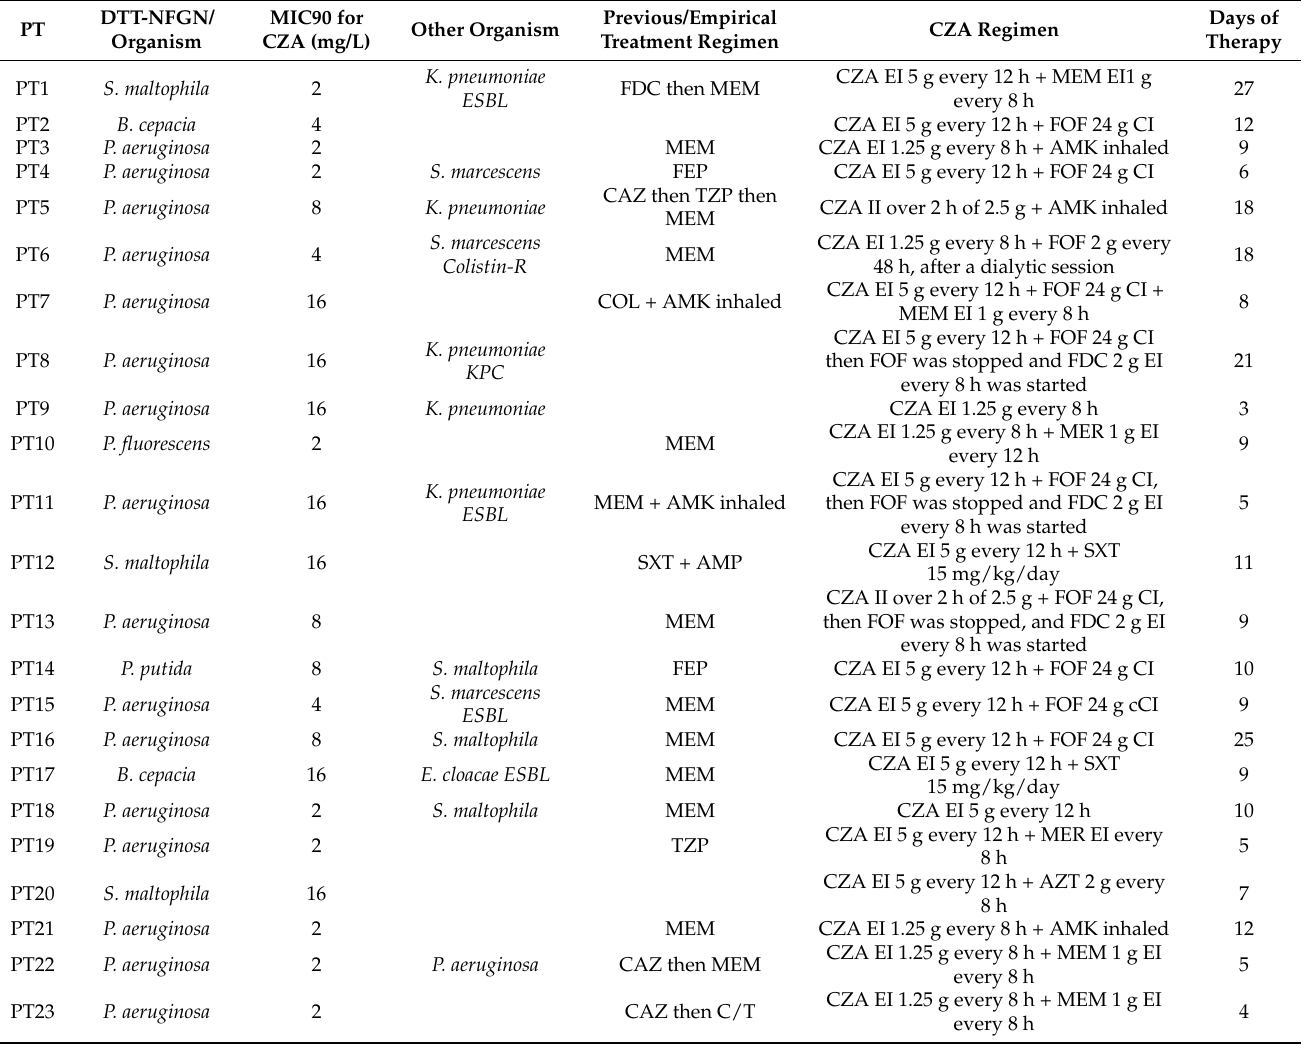
Table 2. Microbiological isolates and treatment